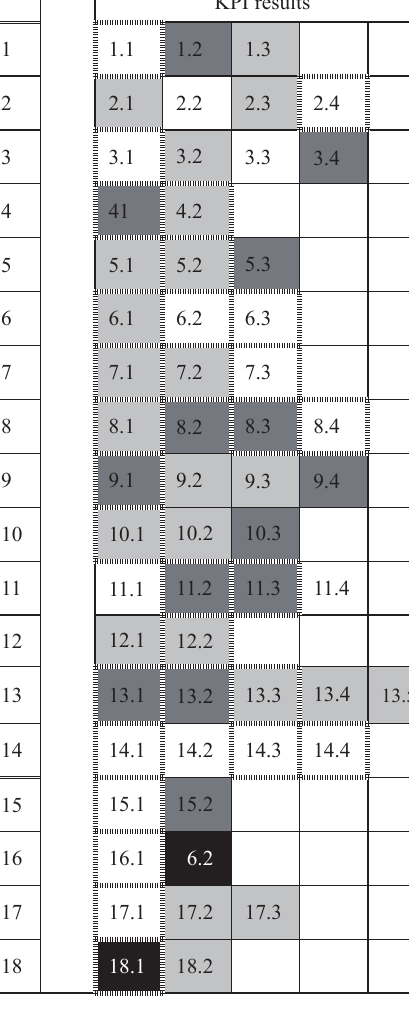
Table 2 Overall performance evaluation results: SEA for the gAENP KPAs KPI